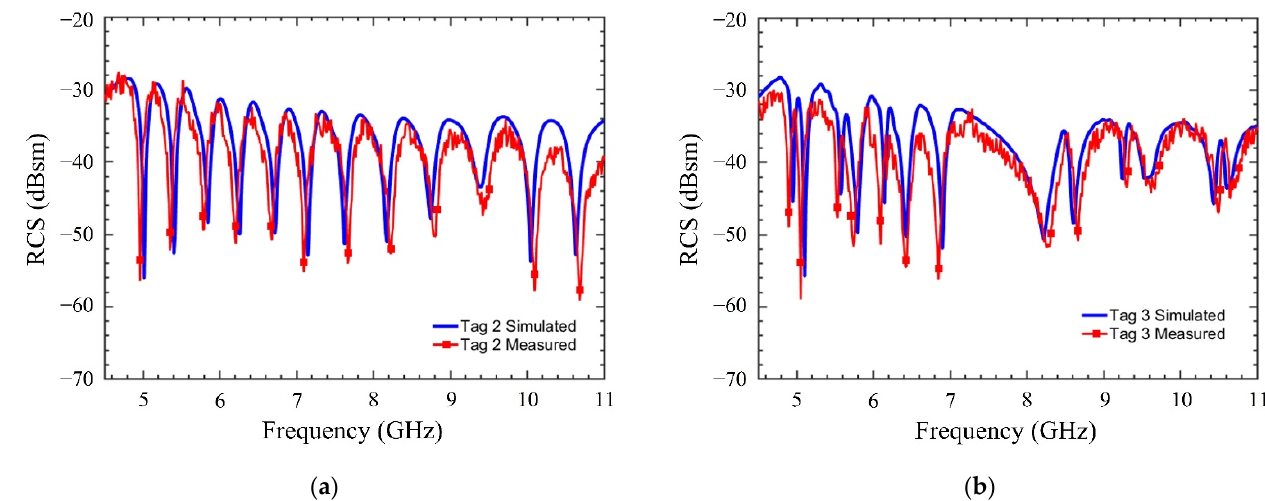
Figure 9. Measured and simulated RCS response of CRFID tag instances: ( a ) Tag 2; ( b ) Tag 3.